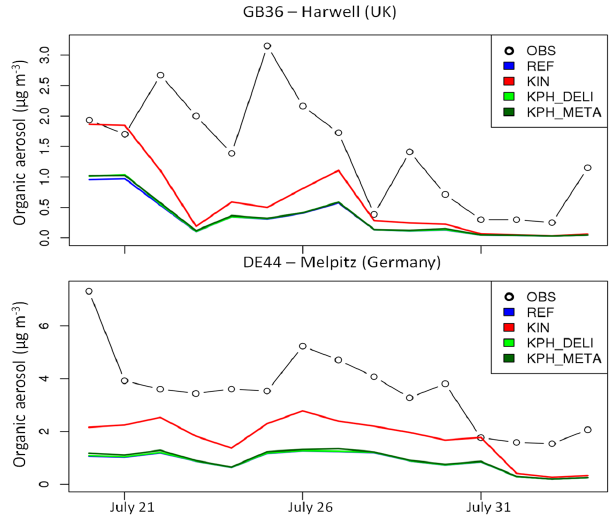
Figure 10. Comparisons of OC measurements (circles) with simu- lated OC in PM 10 obtained in the reference simulation (blue), using the kinetic approach configuration (red), and using both KPH ap- proaches – either in deliquescent or metastable mode (green and dark-green curves, respectively) at the Harwell (UK, top) and Mel- pitz (Germany, bottom) sites during the month of July